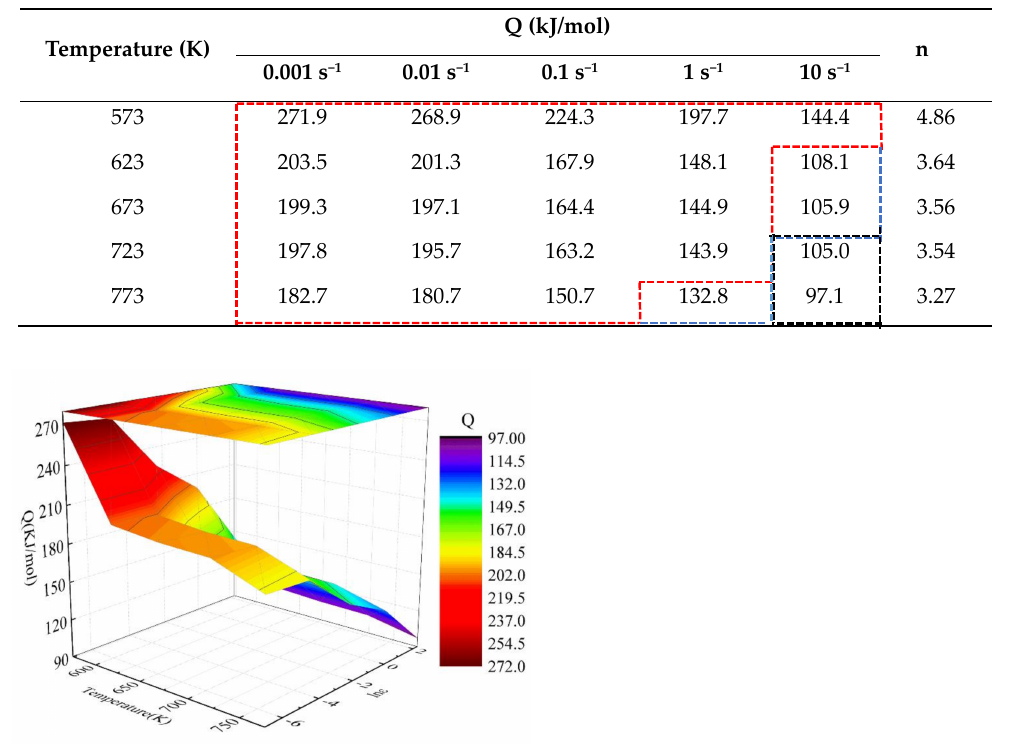
Figure 6. 3D activation energy map of the Mg-2.5Nd-0.5Zn-0.5Zr alloy at a strain of